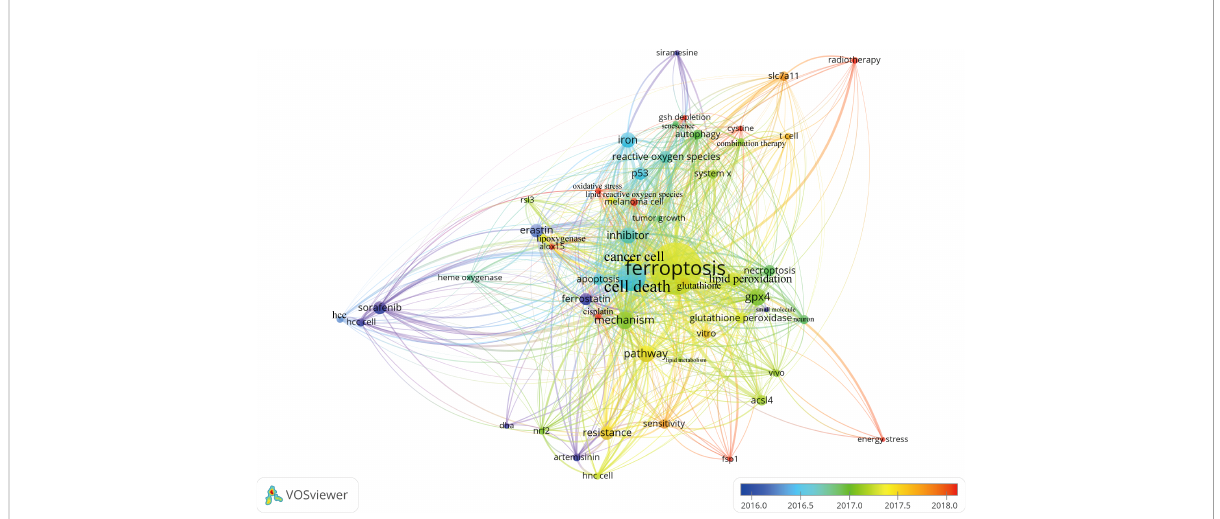
FIGURE 9 Overlay visualization map of terms generated with words from titles and abstracts by VOSviewer. Each node represents a term or phrase and the node size is proportional to occurrences. Distances between nodes indicates relatedness of words in terms of co-occurrence links. Different terms were given different colors based on their